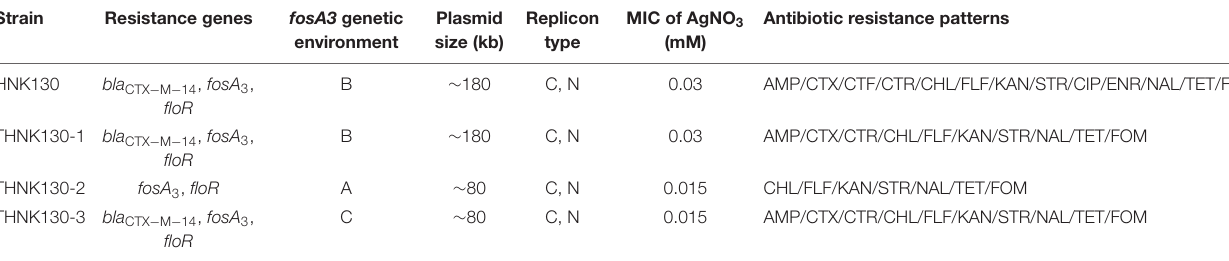
TABLE 1 | Characteristics of HNK130 and its transformants selected for this study. Strain Resistance genes MIC of AgNO 3